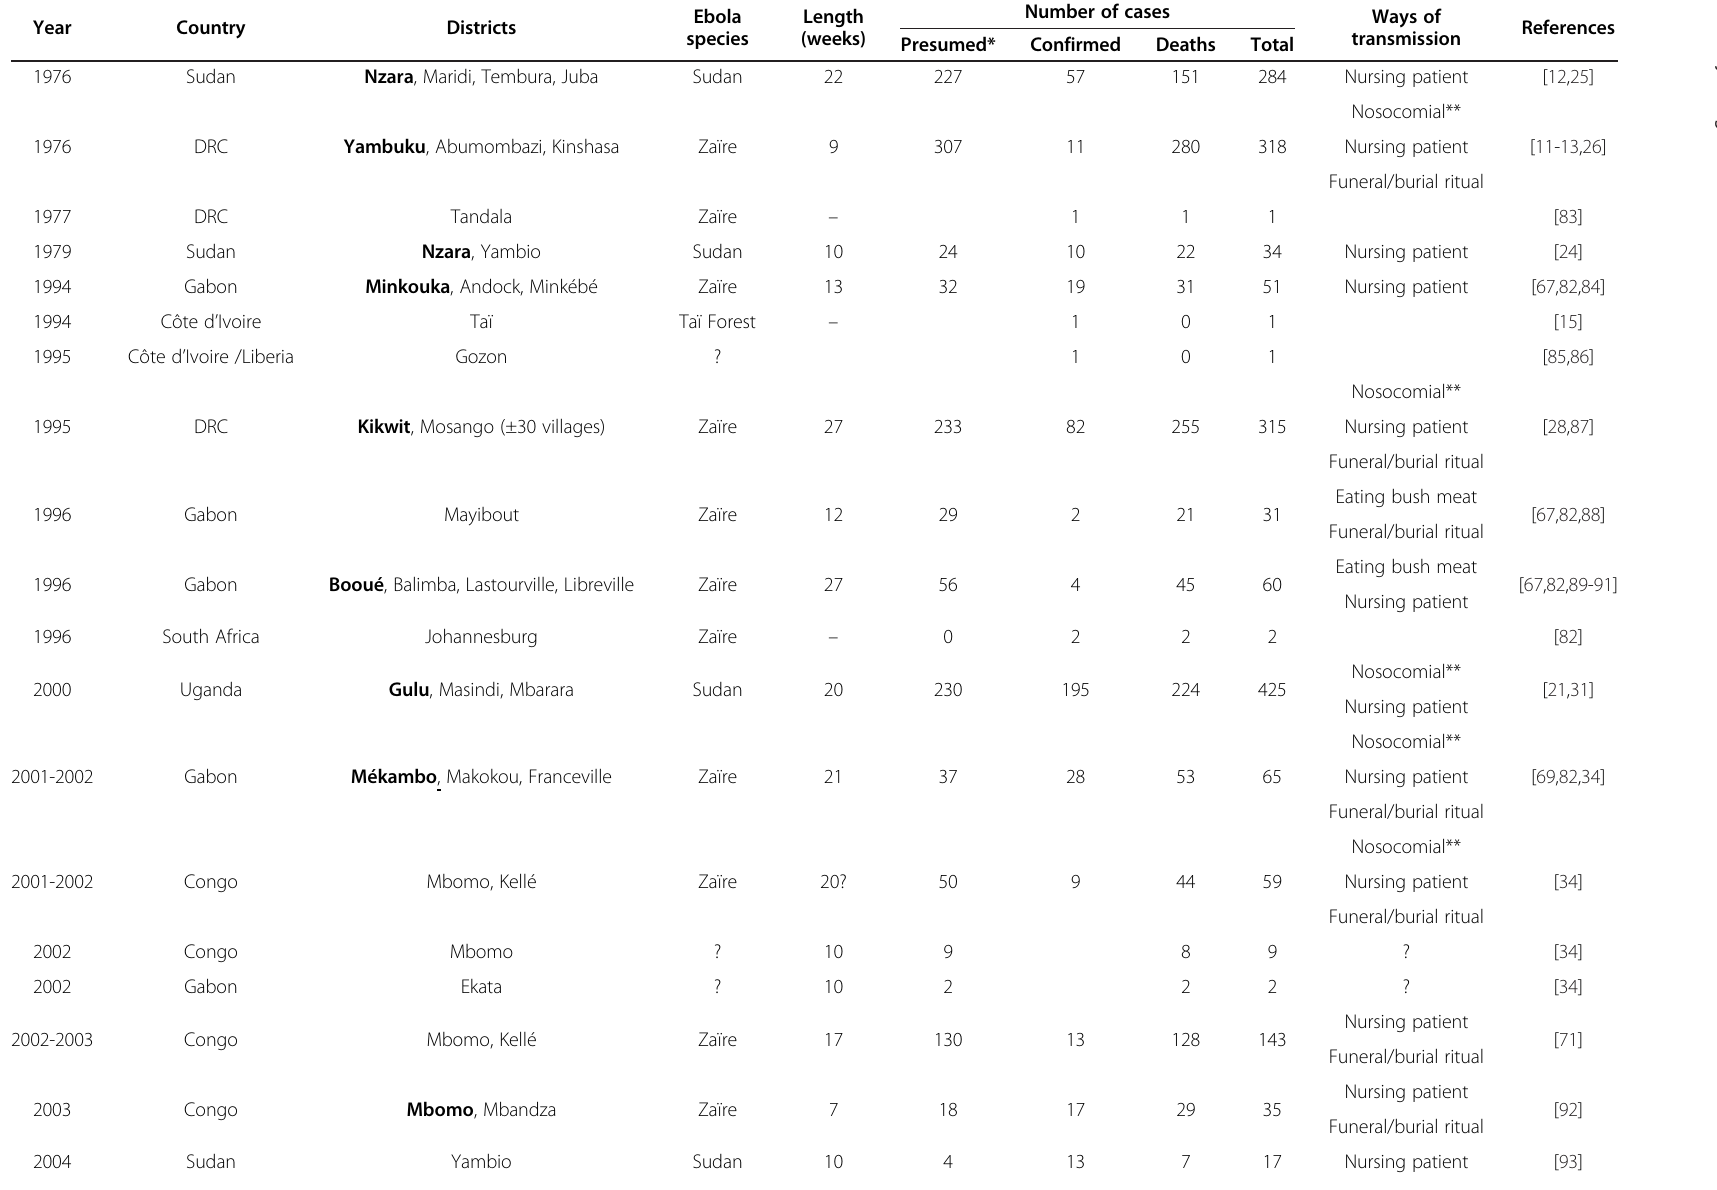
Table 4 Characteristics of the African manifestations of Ebola virus (bolded names indicate the place of first case occurrence)